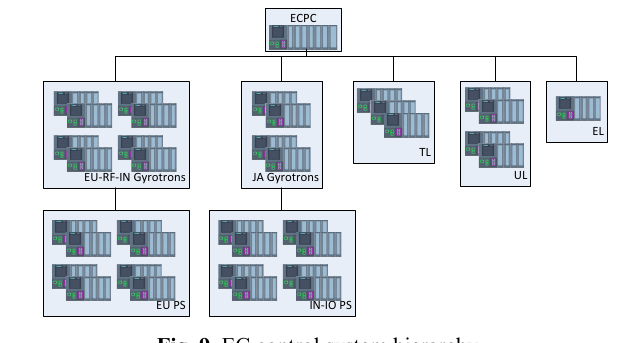
Fig. 9. EC control system hierarchy.